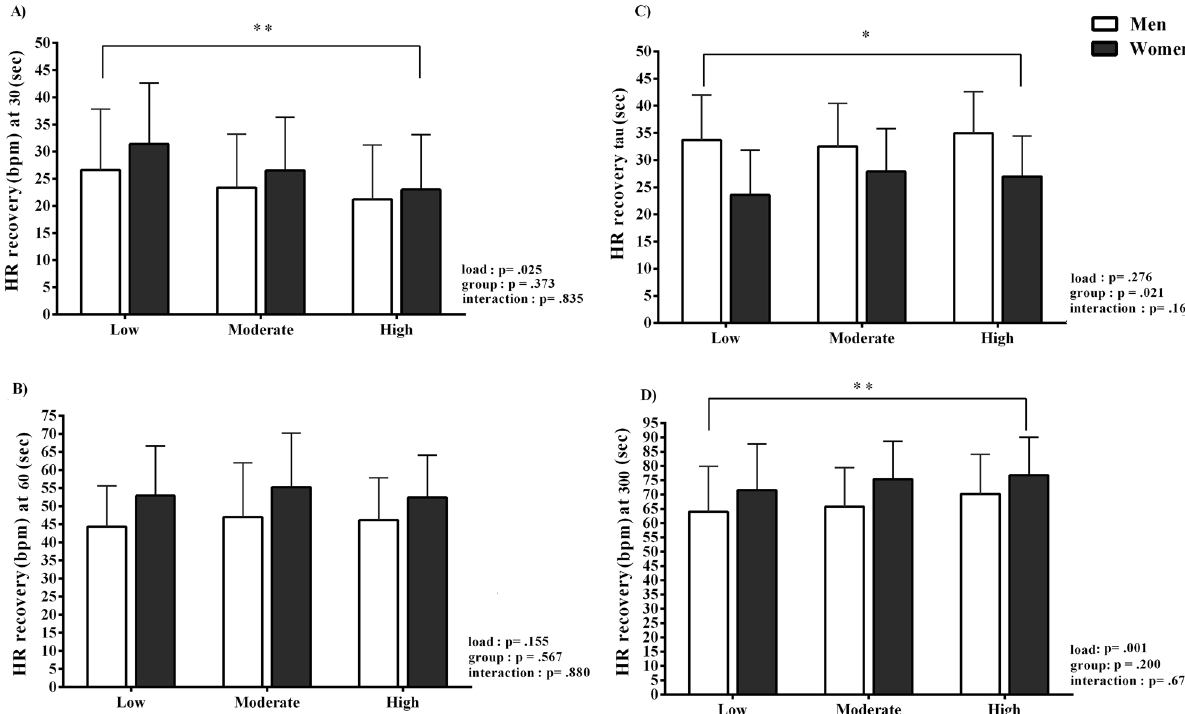
Figure 2. Heart rate recovery after the flywheel exercise. HR recovery heart rate recovery readings measured at 30, 60, and 300 s of recovery, τHRR time constant. *Group effect. **Load